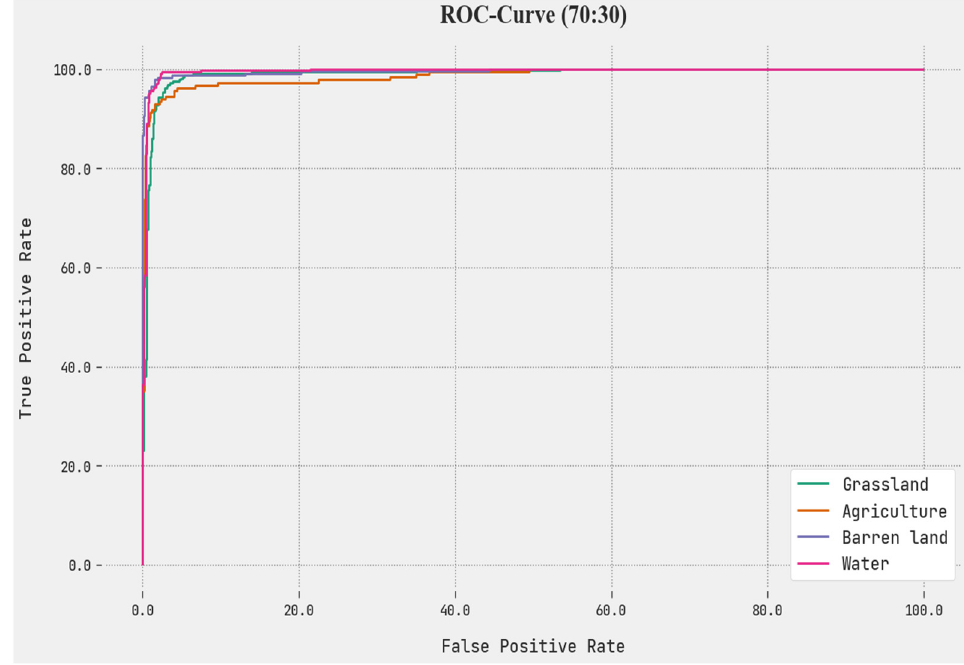
Figure 14. ROC analysis of TSADL-LULCCD approach on 70:30 of TR/TS databases. Table 4. Time Comparison between KNN, LSH with TRT, LSH without TRT Models.